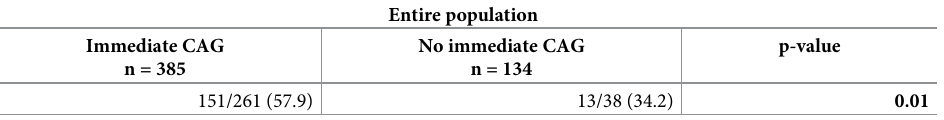
Table 6. Cerebral Performance Category Score 1&2 at discharge in patients with immediate and no immediate CAG.